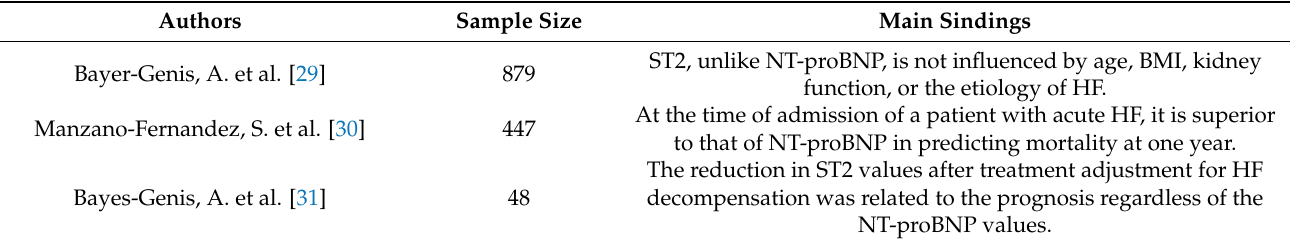
Table 2. ST2 studies in heart